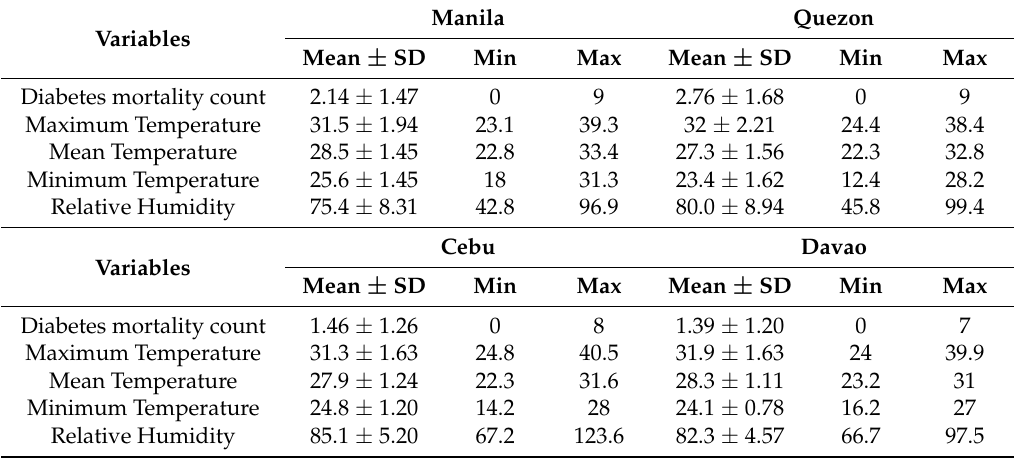
Table 1. City-specific descriptive statistics of the diabetes mortality and meteorological variables, 2006–2011.